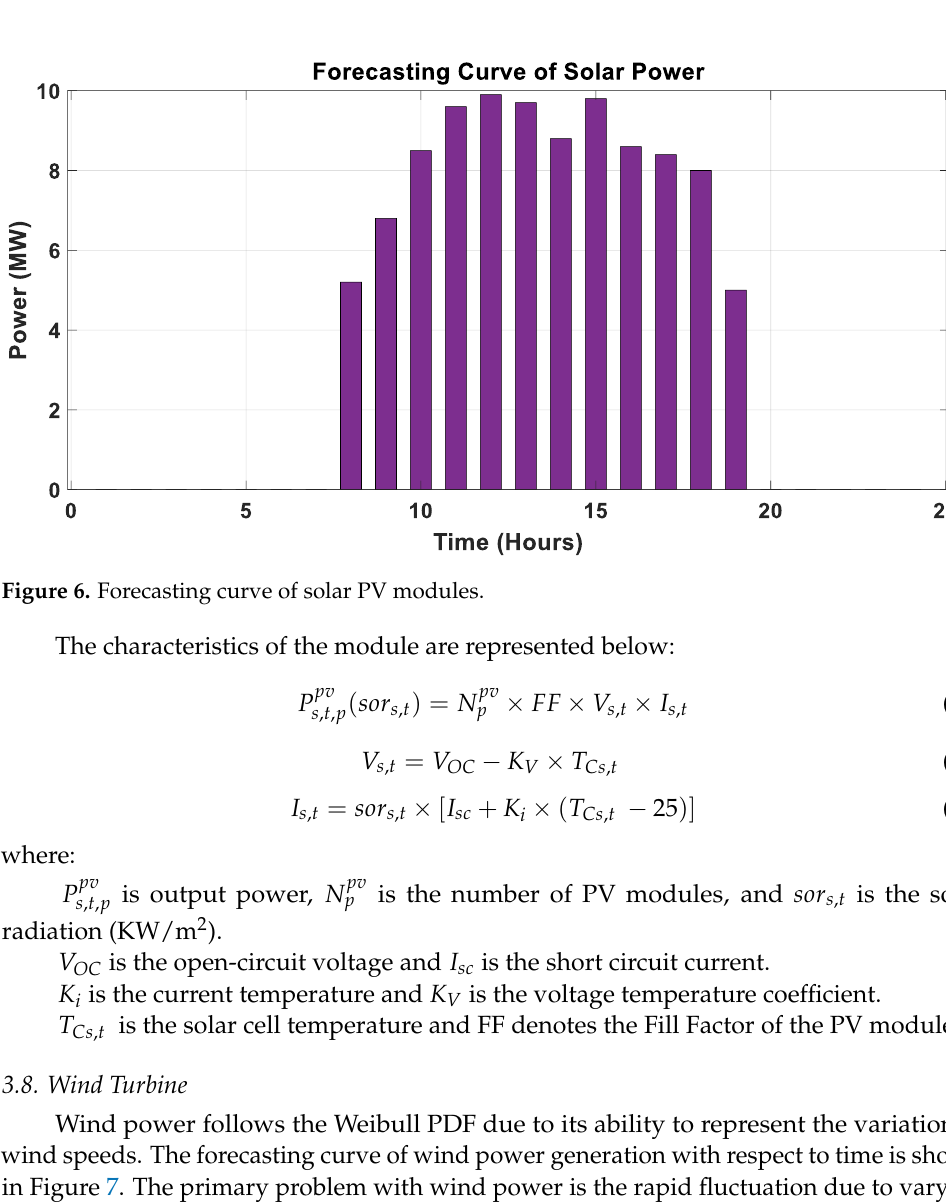
3 Table 4. Parameters for solar PV. 𝑽 𝑶𝑪 (V) 2240 Table 5. Parameters for heat ‐ only units. 𝑯 𝒎𝒂𝒙 , 𝒑𝒉𝒐𝒖 (MWth)